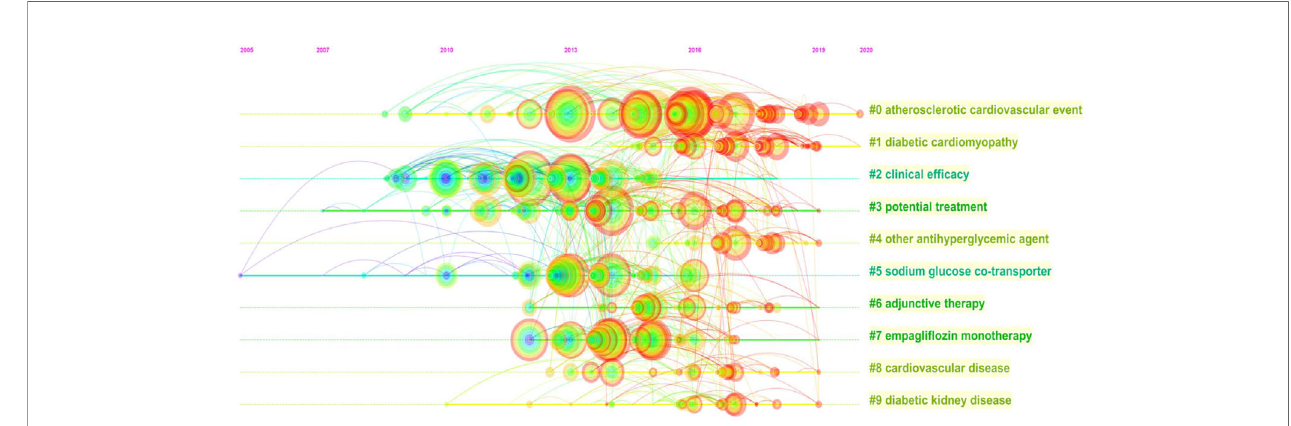
FIGURE 5 | Timeline view of co-cited references related to SGLT2 inhibitors in